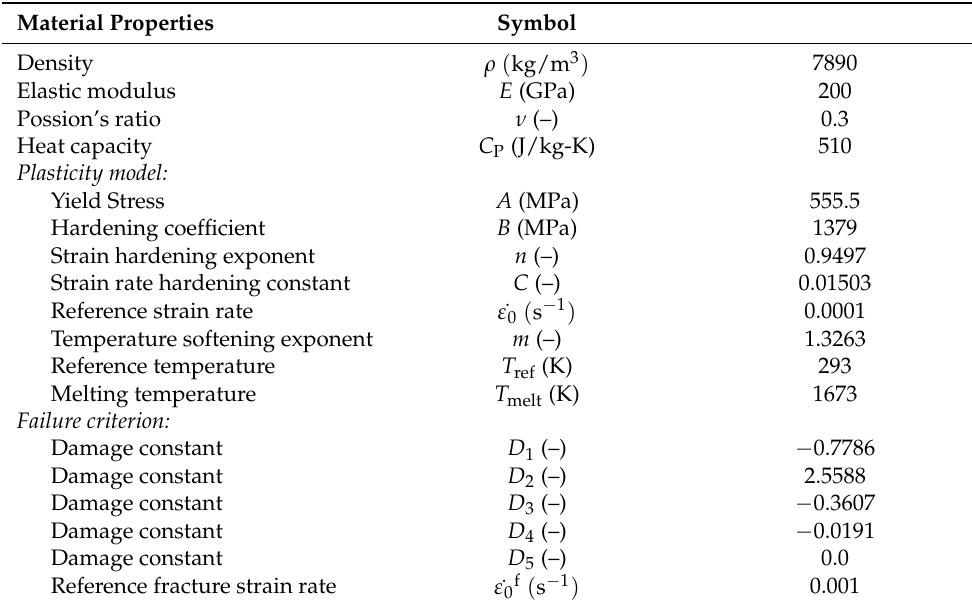
Figure 7. ( a ) Initial geometry employed to study the surface erosion due to solid grains impacts and ( b ) grain shapes, namely octagon, hexagon, square, and rectangle ( top to bottom ). Table 1. Material properties for stainless steel AISI 304